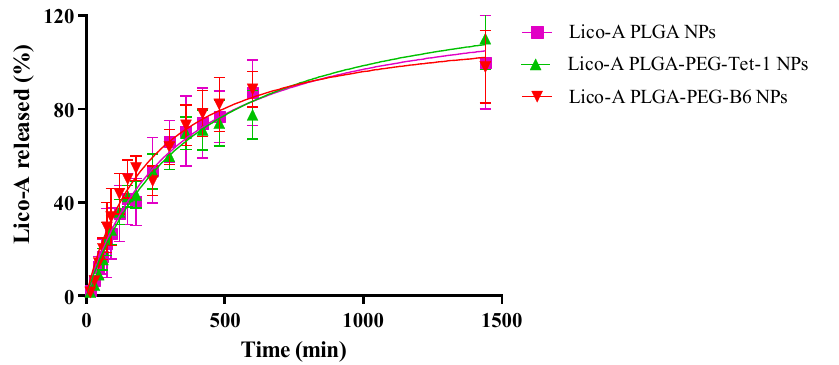
Figure 5. Lico-A release profile carried out by direct dialysis method for studying several formulations (Lico-A PLGA NPs, Lico-A PLGA-PEG-Tet1 NPs, and Lico-A-PLGA-PEG-B6 NPs).